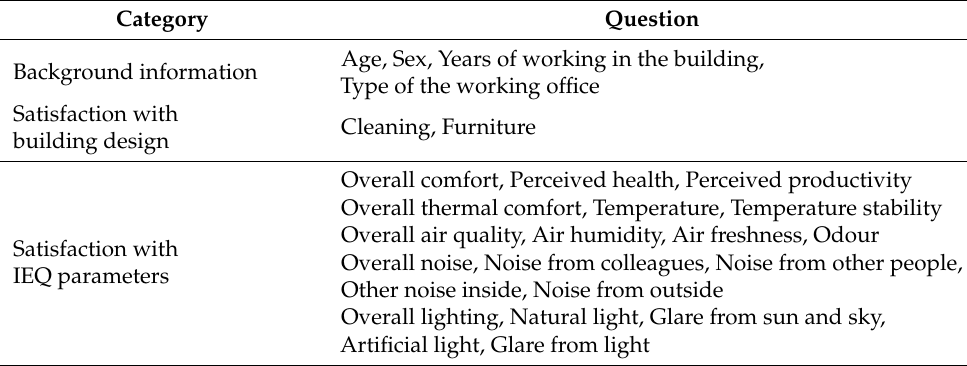
Table 2. Questionnaire